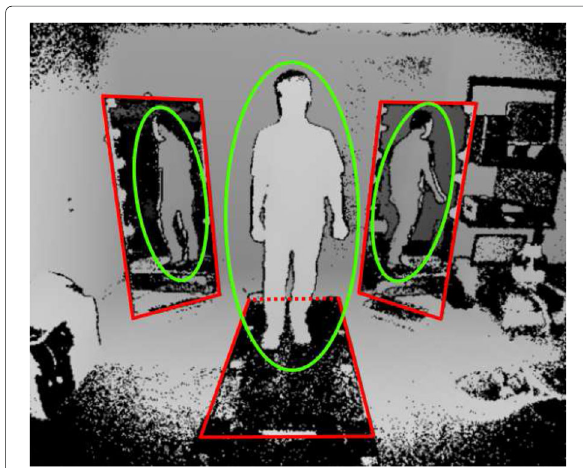
Fig. 1 A depth map captured by our setup that shows 3 devices including two mirrors and a treadmill where each subject performs her/his walking gait. Three collections of subject’s pixels are highlighted by